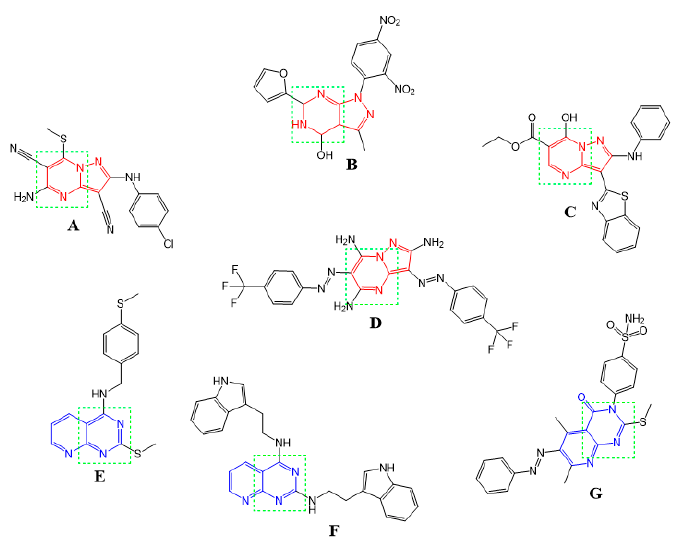
Figure 1. Previously reported cytotoxic compounds: pyrazole-fused pyrimidines ( A – D ) and pyridine-fused pyrimidines ( E – G ).